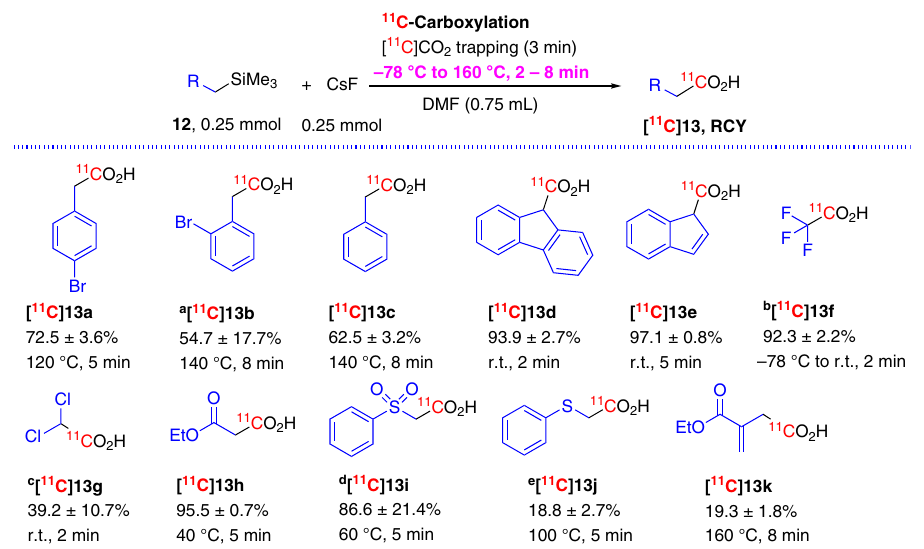
Fig. 4 FMDS 11 C-carboxylation with sp 3 -hybridized carbon attached trimethylsilanes. a Precursor (0.05 mmol, 12 mg), DMF (0.3 mL); b Reaction vial was maintained at r.t. for 2 min after [ 11 C]CO 2 collection was done at − 78 °C, THF as solvent; c Solvent DMF (0.25 mL) + THF (0.5 mL); d Precursor is highly moisture sensitive; e RCY based on n =